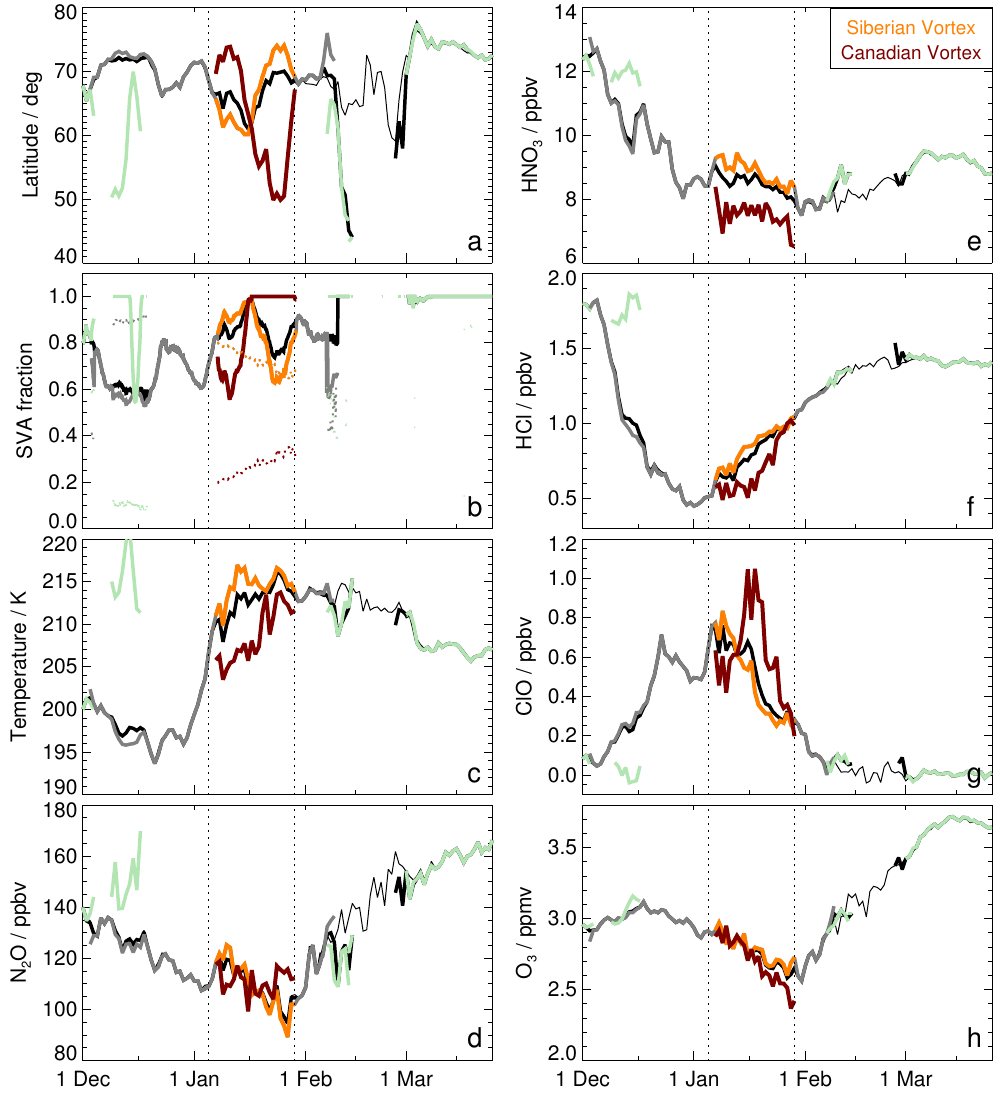
Figure 11. Characteristics of individual offspring vortices in 2012/13 at 490K: (a) vortex-averaged latitude (degrees), (b) SVA expressed as a fraction of the vortex area (fine dotted lines show the fraction of total vortex area in each offspring vortex), vortex-averaged MLS (c) temperature, (d) N 2 O, (e) HNO 3 , (f) HCl, (g) ClO, and (h) O 3 . Thick black lines show the fields for the sum over all vortices with area greater than 1% of a hemisphere; thin black lines in vortex-averaged plots show “bulk” average (including individual regions with area less than 1% of the hemisphere). Individual vortices are shown as thick grey and colored lines, with the “Siberian” and “Canadian” vortices in January shown in orange and dark red, respectively, and smaller offspring vortices at other times in light green. Thin vertical dotted lines are on 6 January (the onset of the major SSW, ∼ 2 days before the vortex split) and 30 January (when the offspring vortices merged).